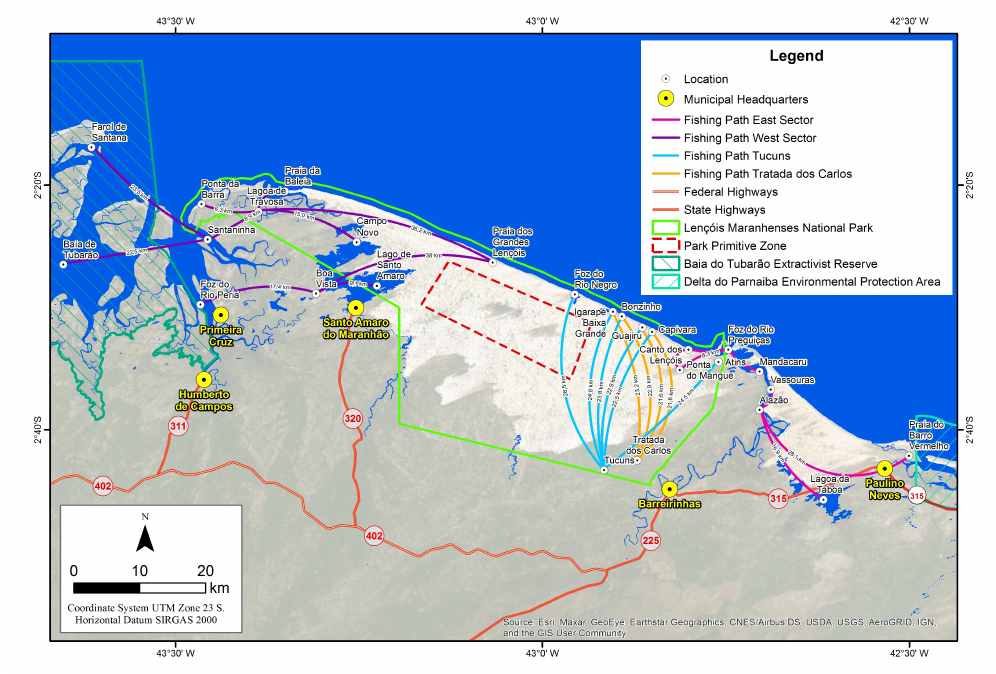
Figure 8. Travelling paths are used by the local inhabitants for various